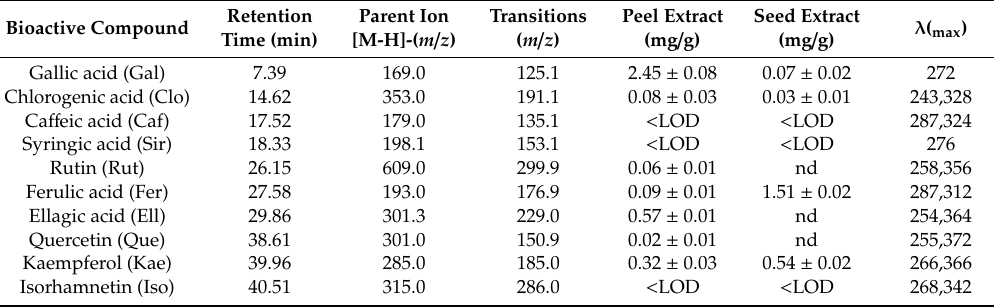
Table 2. Bio-active contents in melon peel and seed extracts (UV-Vis, HPLC and MS